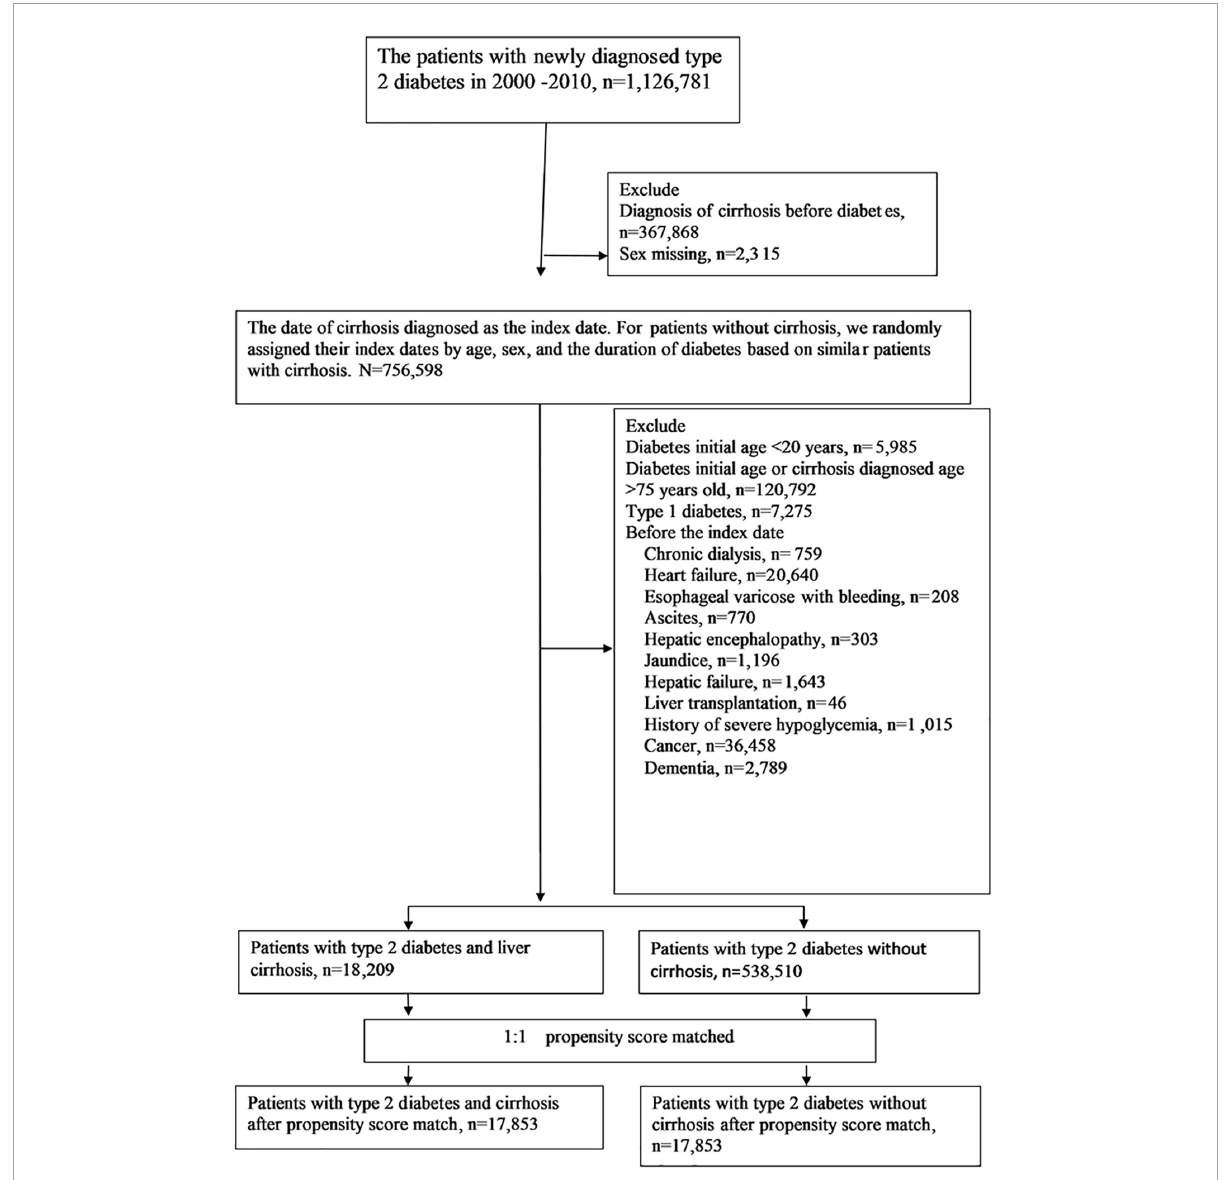
FIGURE1 Flowchart of the selection of cohorts from the National Health Insurance Research Database.